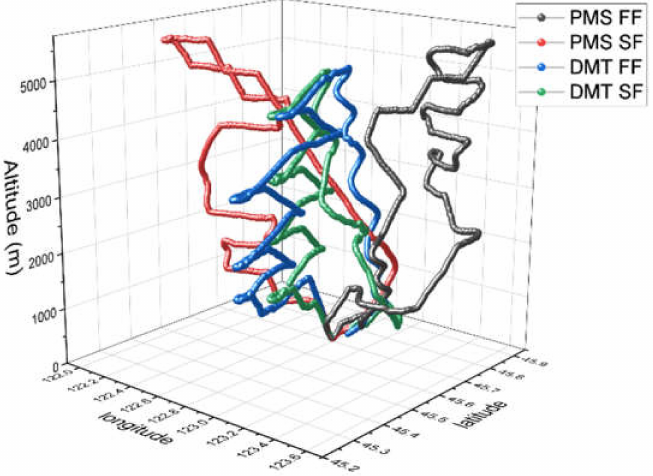
Figure 1. Three-dimensional trajectory diagram of the two aircraft (black: PMS aircraft first flights (PMS FF), red: PMS aircraft second flights (PMS SF), blue: DMT aircraft first flights (DMT FF), green: DMT aircraft second flights (DMT